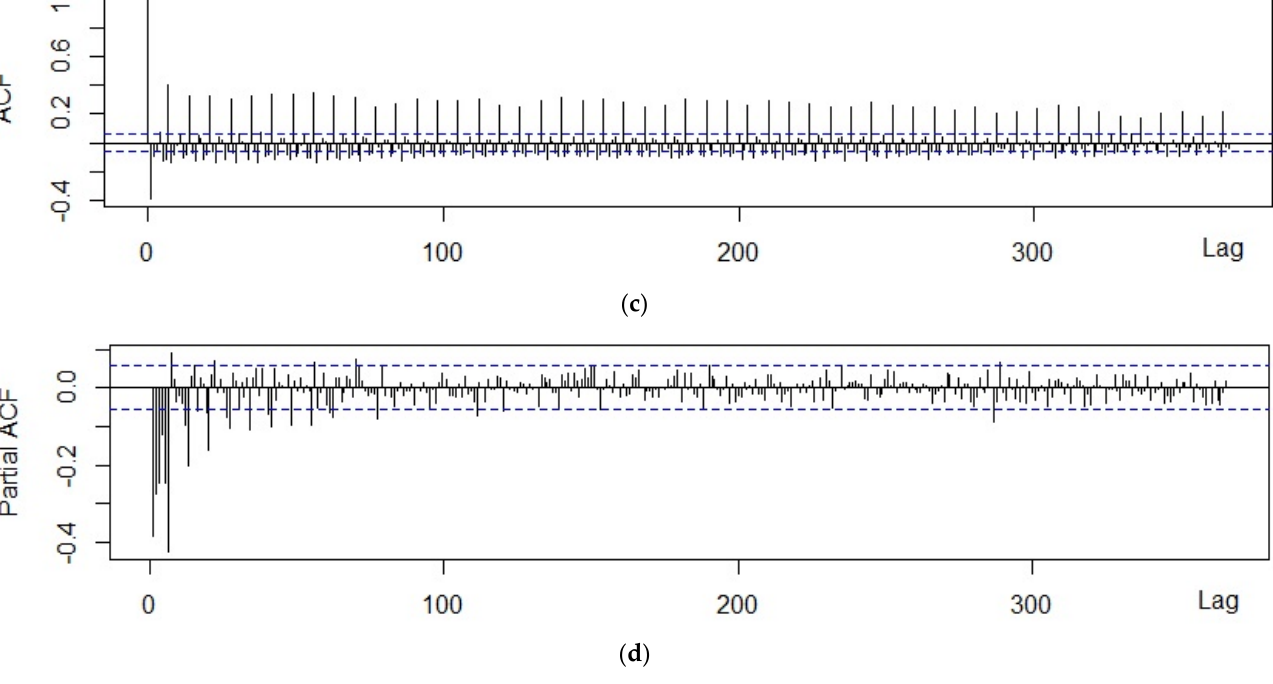
Figure A4. Autocorrelation function (ACF) of the Moran’s I b for Candies prices of the original time series ( a ) and of the first differences ( c ); Partial autocorrelation function (PACF) of the Moran’s I b for Candies prices of the original time series ( b ) and of the first differences ( d ). The Moran’s I b indexes are calculated based on binary contiguity matrices.